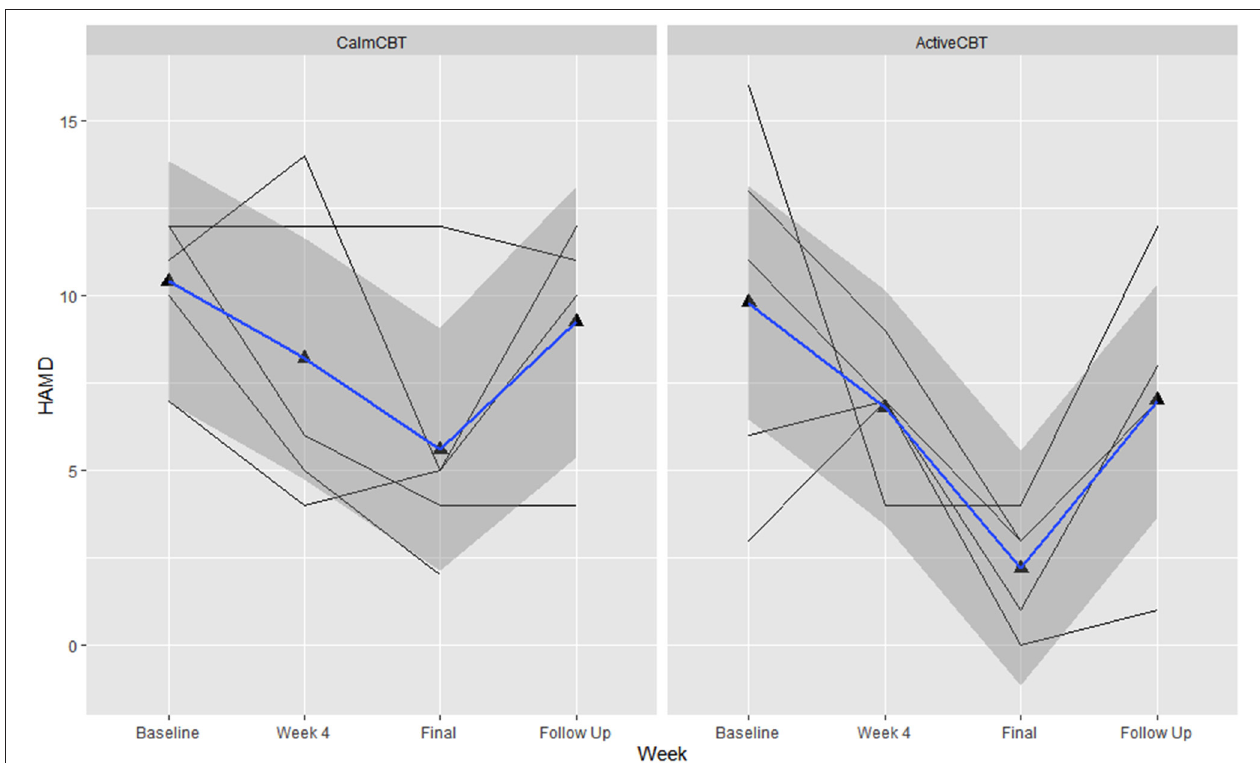
FIGURE 7 | Changes in depression symptom severity on the Hamiilton Rating Scale of Depression-17 (HAMD) across the intervention. Data are total scores of the interviewer-administered HAMD self-reported at baseline, the final visit, and 3-month follow-up. Higher values indicate greater symptom severity, with values over 10 indicated moderate to severe depressive symptoms. B, baseline; F, final assessment; FU, 3-month